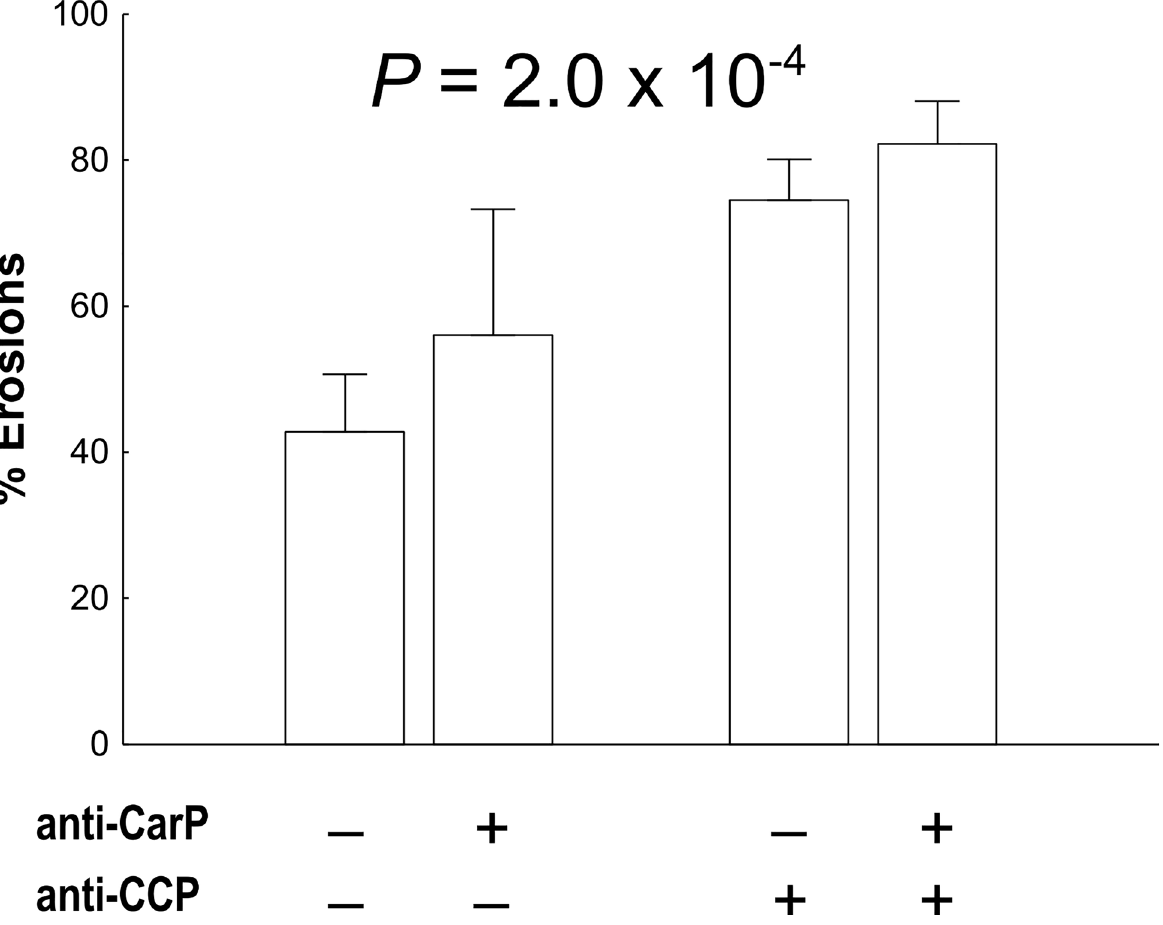
Fig 3. Prevalence of RA bone erosions in anti-CCP and anti-CarP defined subgroups. Error bars represent 95% CI. P value from logistic regression analysis adjusted for gender, age of diagnosis and time of follow-up.